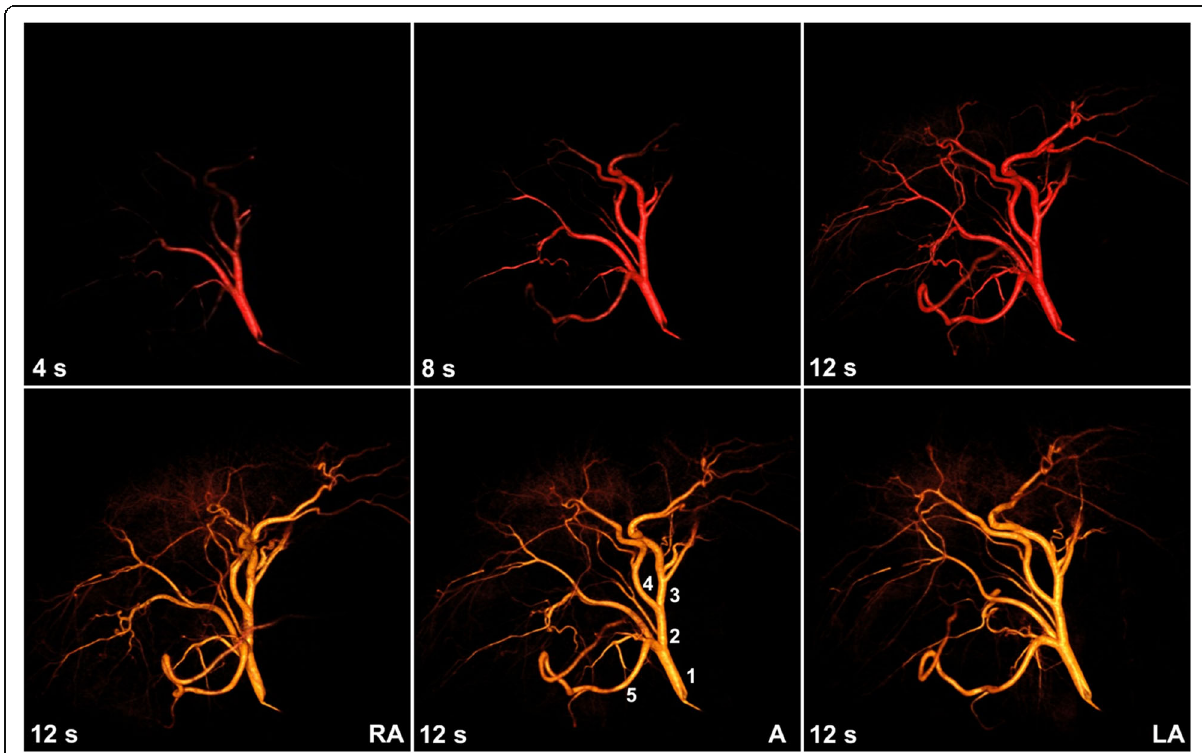
Fig. 1 Hepatic 4D-DSA. Upper row shows the hepatic vasculature from an anterior projection with three different time frames at 4, 8, and 12 s; lower row shows the final time frame from three different angles (A, anterior; RA, right anterior; LA, left anterior). Similar images can be obtained for any time frame or angle. The hepatic artery numbering is as follows: 1, common hepatic (1st order); 2, left hepatic (2nd order); 3, left medial (3rd order); 4, left lateral (3rd order); and 5, gastroduodenal (2nd